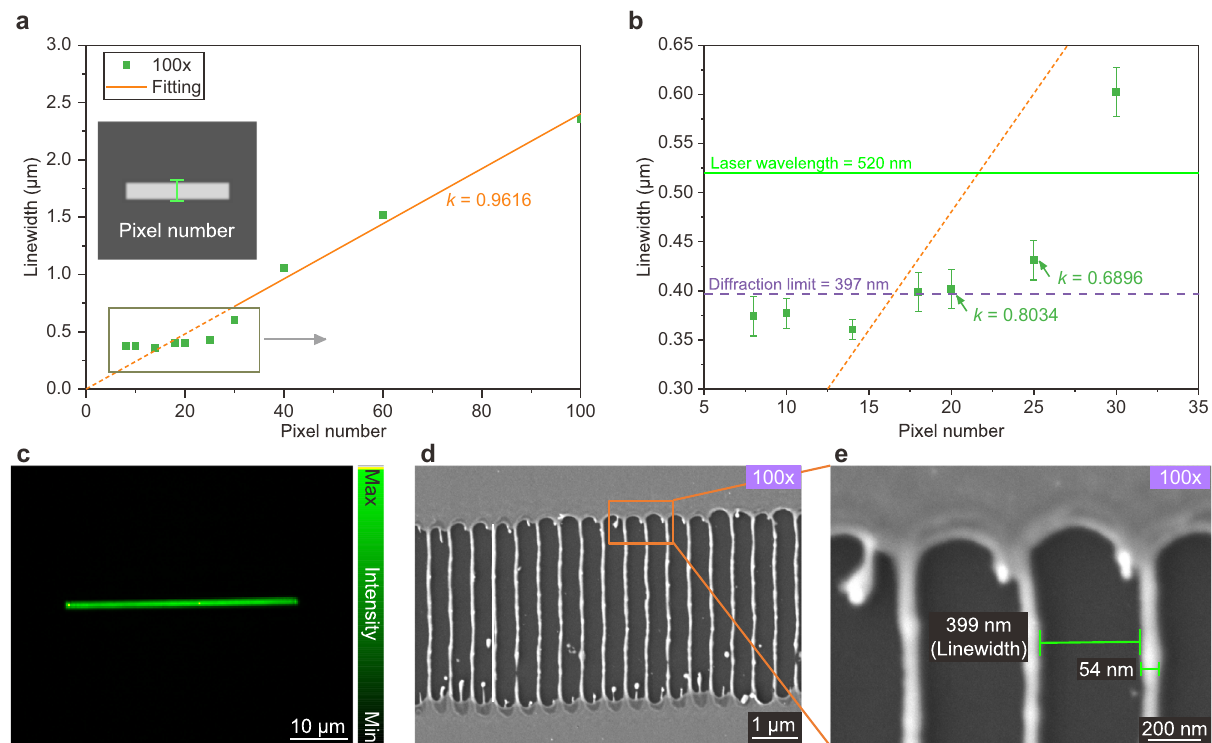
c Beampro fi leofthelinepulsemodulatedbyaphasemaskwith14-pixellinewidth. d , e GratingsproducedbyPPLLwithaperiodof453nmandremaininglinewidthof 54nm (laser-ablated linewidth is 399nm) by pulse energy of 0.07 μ